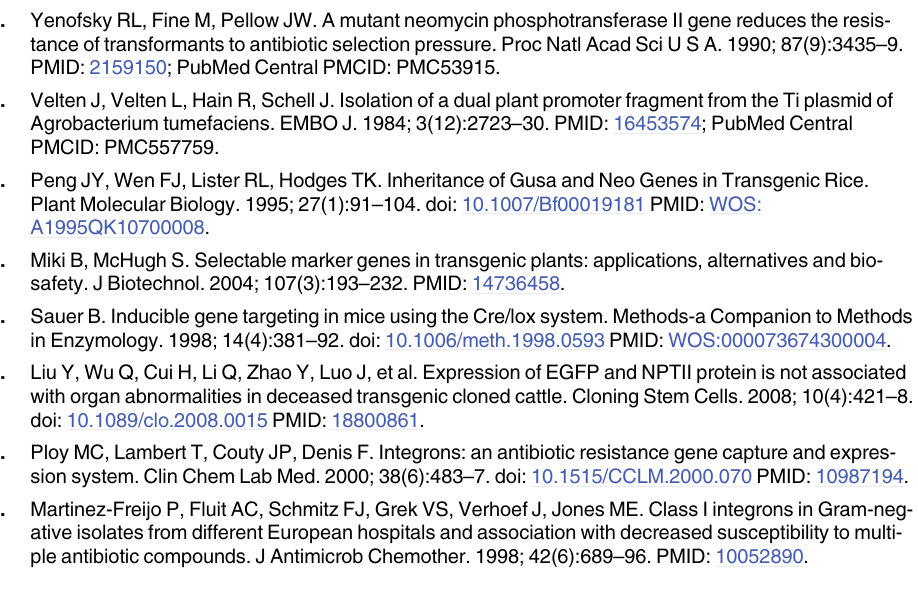
S2 Table. Comparative analysis of the relative abundance of six phyla in different intestinal sections from transgenic and non-transgenic pigs in Group B. S3 Table. Comparative analysis of the relative abundance of bacterial genera in different intestinal sections from transgenic and non-transgenic pigs in Group B. S4 Table. Overview of pyrosequencing results for fecal samples in Group A collected at var- ious time points post antibiotic feeding. S5 Table. Overview of pyrosequencing results for fecal samples in Group B collected from different intestinal